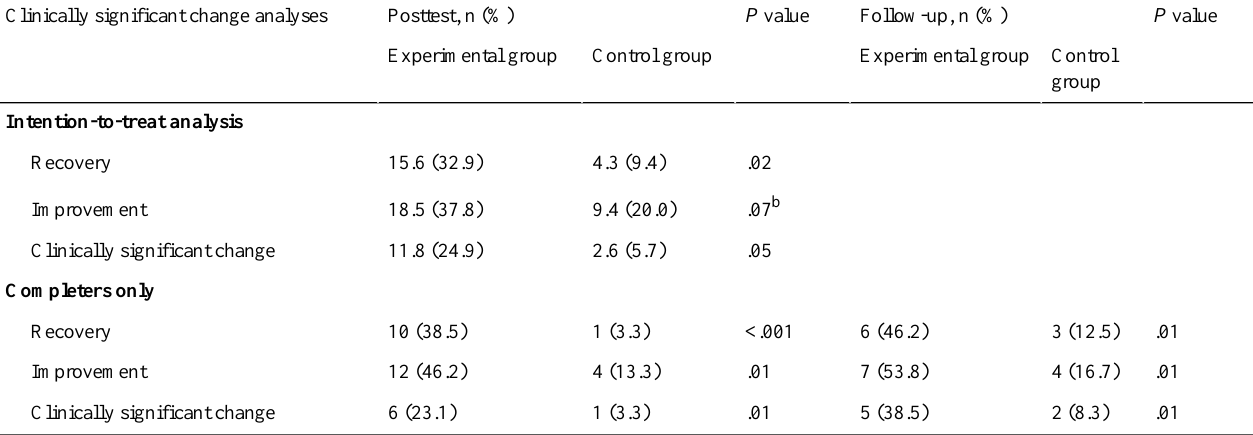
Table 3. Clinically significant change analyses of depression tested by the